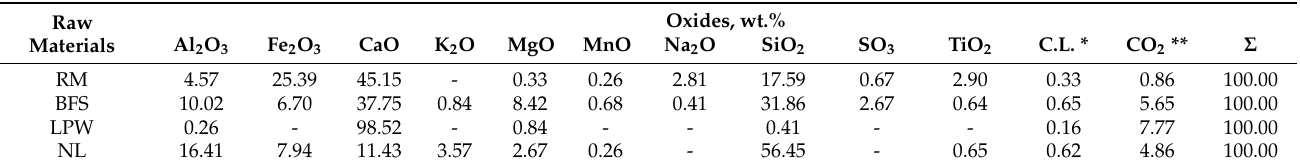
Table 3. Chemical composition of the raw